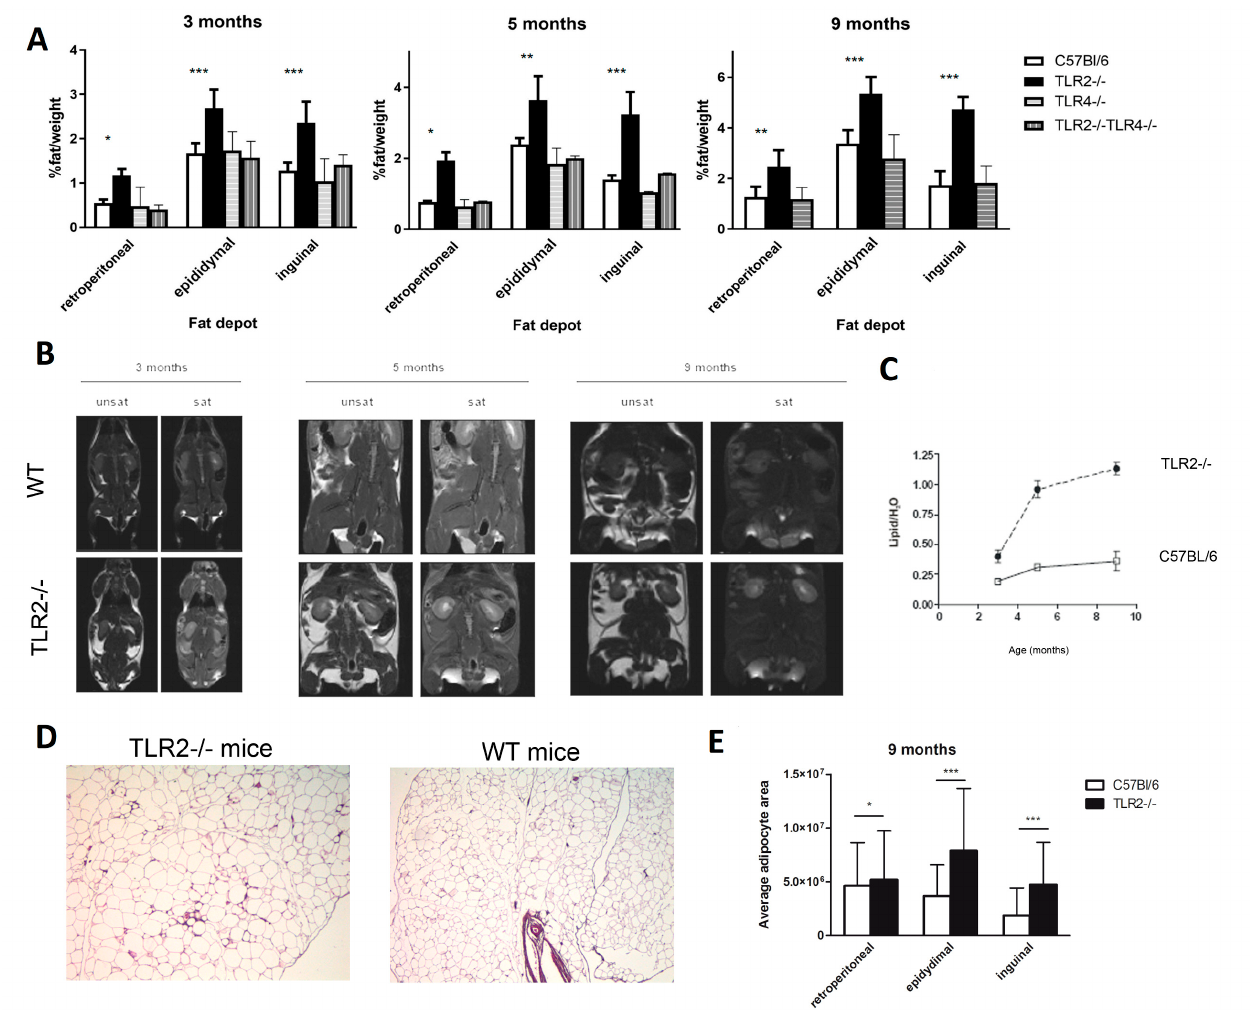
Figure 3. TLR2 − / − mice develop excess adiposity. ( A ) Relative weights of different fat depots isolated from TLR2 − / − , TLR4 − / − , TLR2 − / − -TLR4 − / − , and WT mice. The relative fat mass was expressed as a percentage of body weight (n = 4, two-way ANOVA, * p < 0.05, ** p < 0.01, *** p < 0.001 between TLR2 − / − mice and WT mice). Values are represented as mean ± s.d. ( B ) NMR images of whole-body horizontal sections were taken at the approximate midline. White density denotes fat. ( C ) Quantification of lipid in WAT based on spectroscopy of lipid and water peaks. (n = 3 per group, two-way ANOVA, ** p < 0.01). Values are represented as mean ± s.d. ( D ) Histology of the epidydimal WAT of TLR2 − / − and WT mice (hematoxylin-eosin staining; scale bar, 200 μ m). A representative picture is shown at 7 months of age ( E ) Average adipocyte area measured in histology sections from different fat depots of TLR2 − / − and WT mice. (n = 3 per group, two-way ANOVA, * p < 0.05, *** p < 0.001). Values are represented as mean ± s.d.